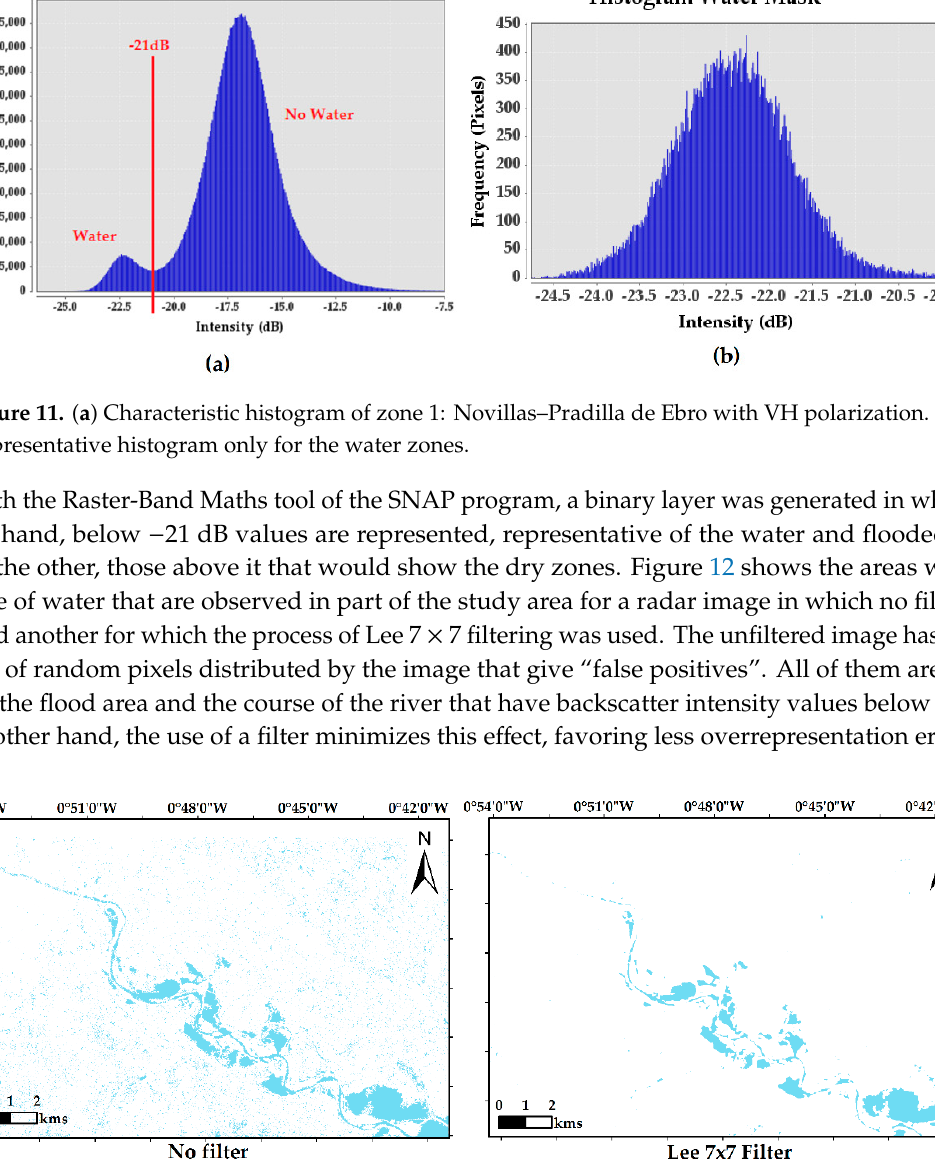
Figure 12. Representation of a specific part of zone 3: Zaragoza–El Burgo de Ebro (the same represented in Figure 5) of the areas that were captured as water in the unfiltered radar image and another with the Lee 7 × 7 filter.